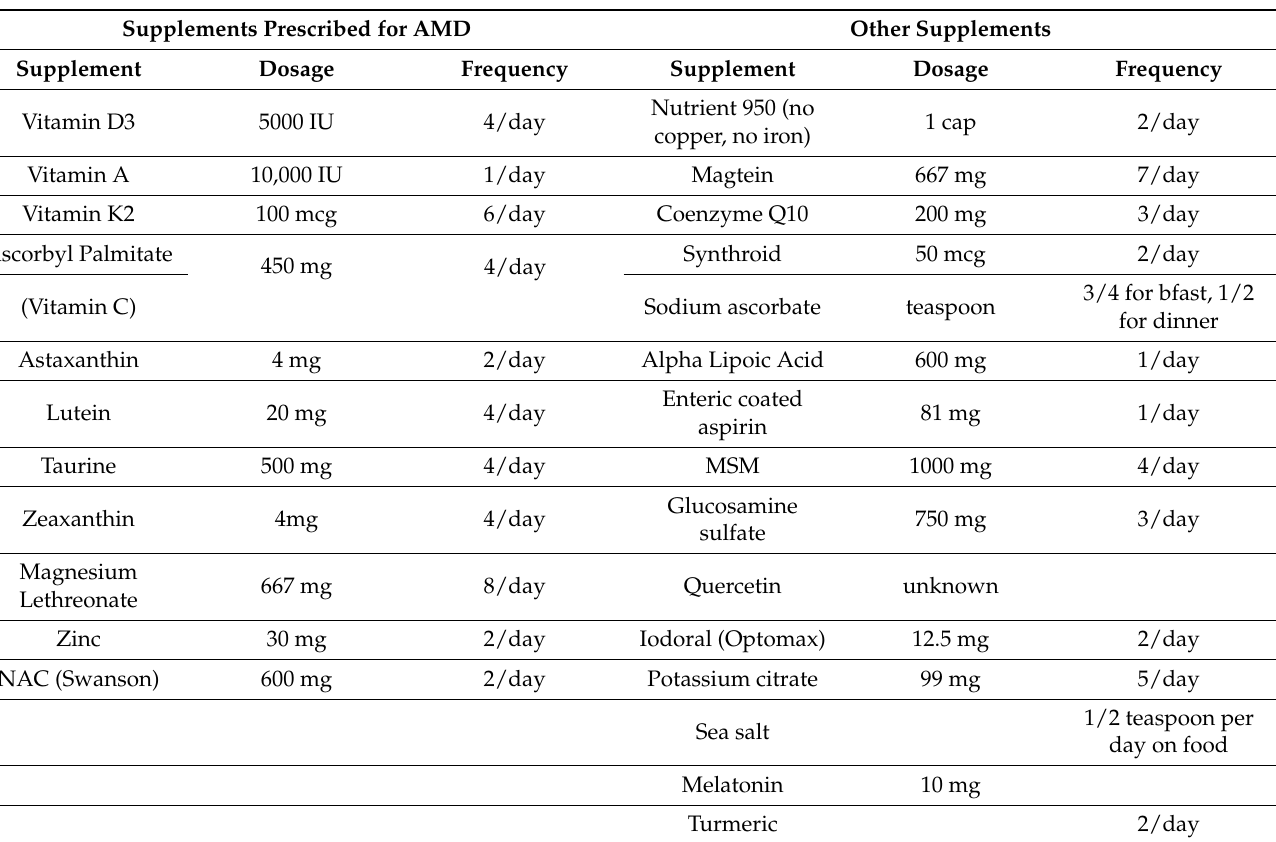
Table 1. Daily dietary supplements prescribed to patient by orthomolecular medicine